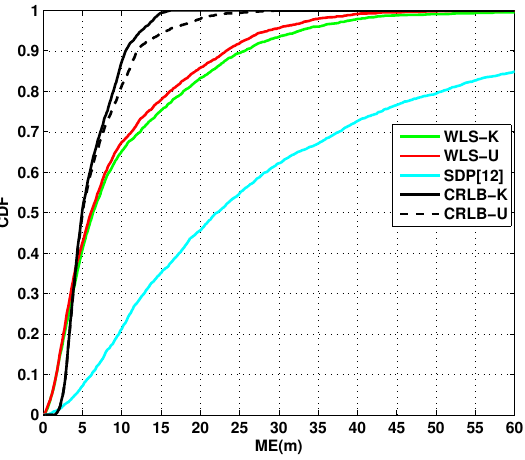
Figure 6. Cumulative density function (CDF) versus mean error (ME) when σ = 4 dB, α f = 0.1 dB/m ( f = 454 kHz), N = 10, and ρ =